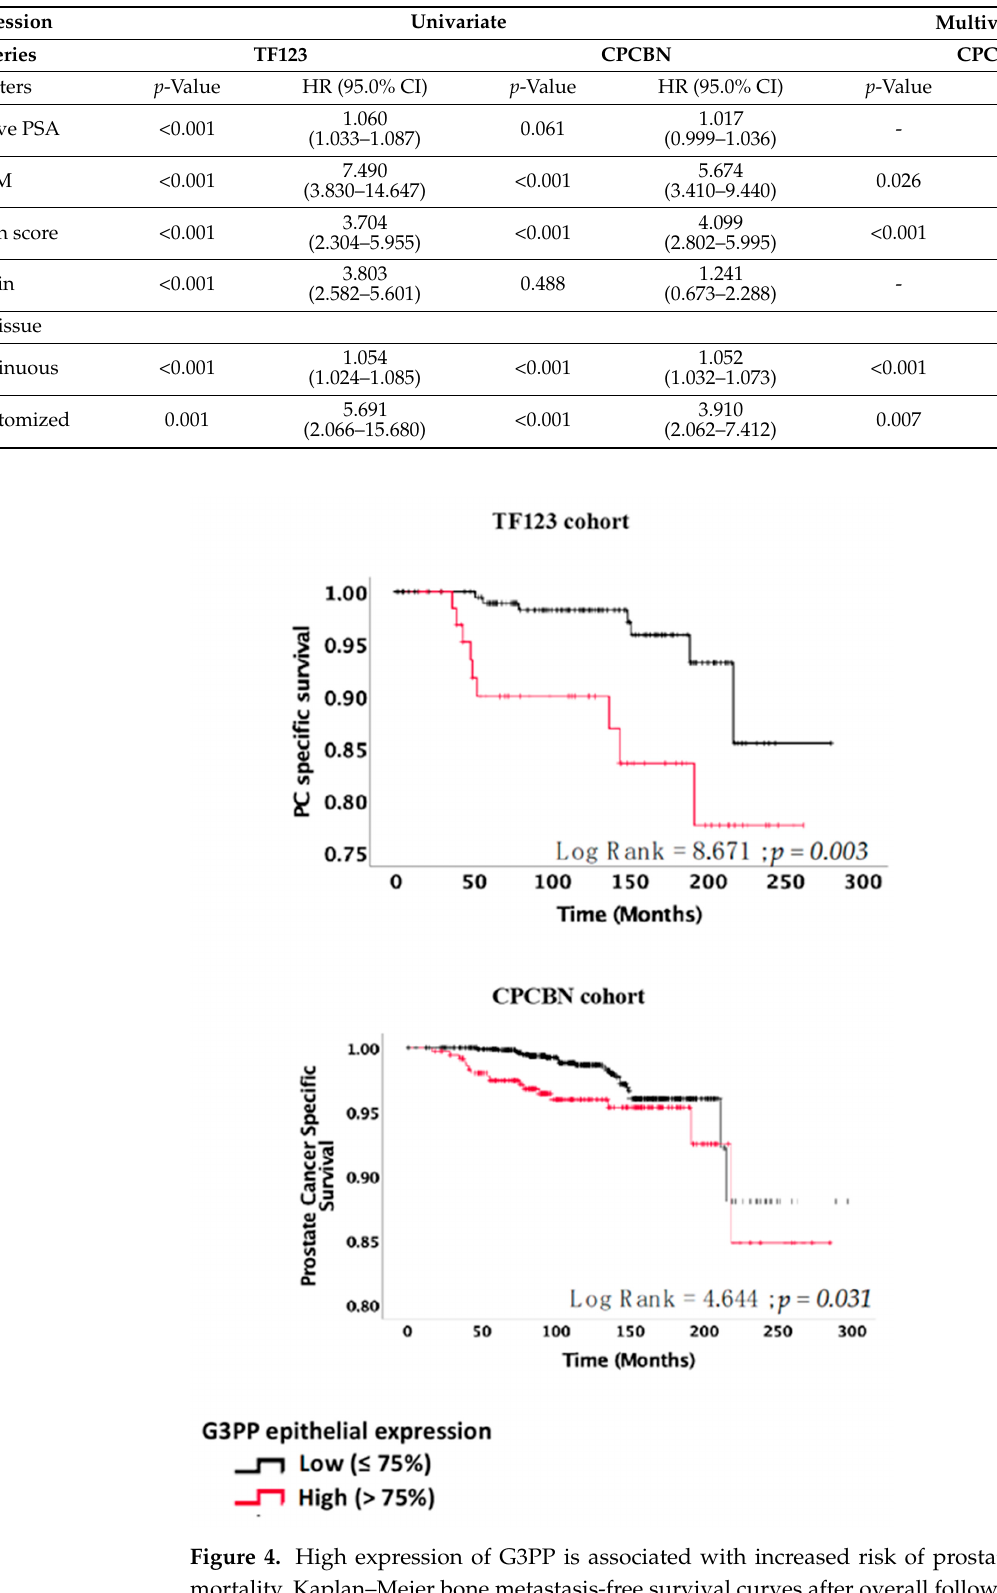
Table 3. Univariate and multivariate Cox regression analyses predicting bone metastasis development in the TF123 and CPCBN TMA cohorts after 10 years of follow-up.